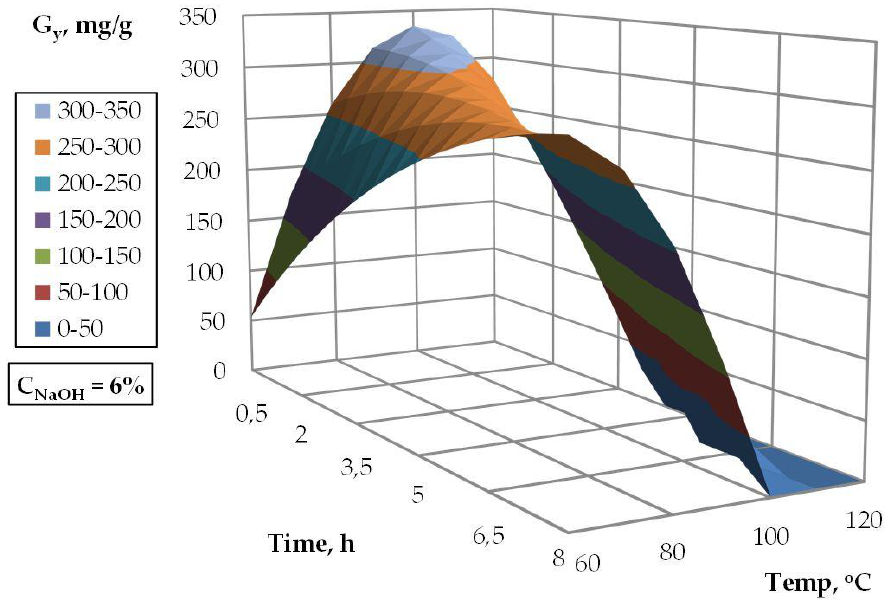
Figure 4. The surface response plots of the effects of temperature and time on the glucose yield.